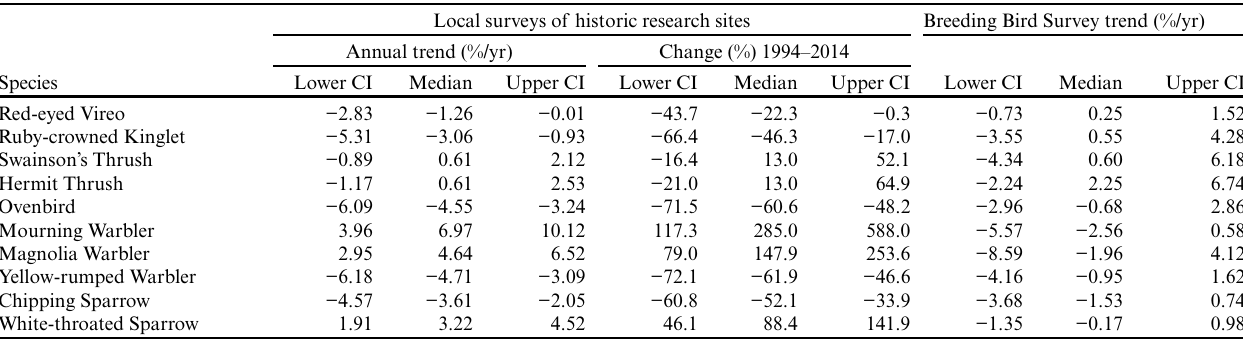
Table 3. Estimated change in avian abundance in deciduous-dominated mixedwood stands of central Saskatchewan from revisits to historic research sites (circa 2004, 2014) estimated from generalized linear mixed-effects models compared with trends from the North American Breeding Bird Survey (Boreal Taiga Plains stratum). Upper and lower CIs denote Bayesian credible